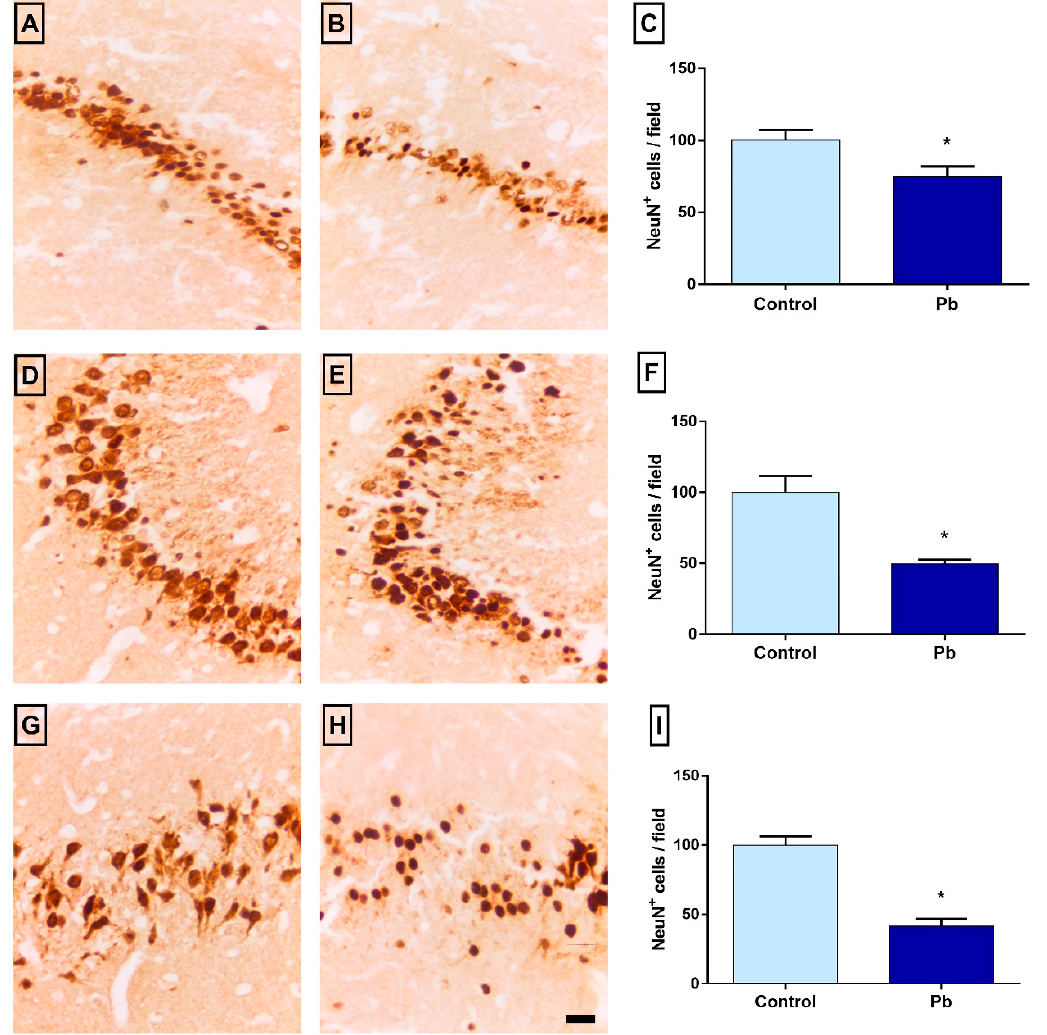
Figure 5. Immunostaining for anti-NeuN in the hippocampus. Representative photomicrographs of CA1, CA3 and hilus in control ( A , D and G , respectively) and Pb-exposed group ( B , E and H , respectively). Graphs with a quantitative representation of the differences between the number of NeuN + cells in the respective areas: CA1 ( C ), CA3 ( F ) and hilus ( I ) expressed as mean ± Standard Error of Mean (S.E.M.) of the cell number per field in each region. * p < 0.05 compared to the control group (Student's t-test). Scale bar: 20 μ m.